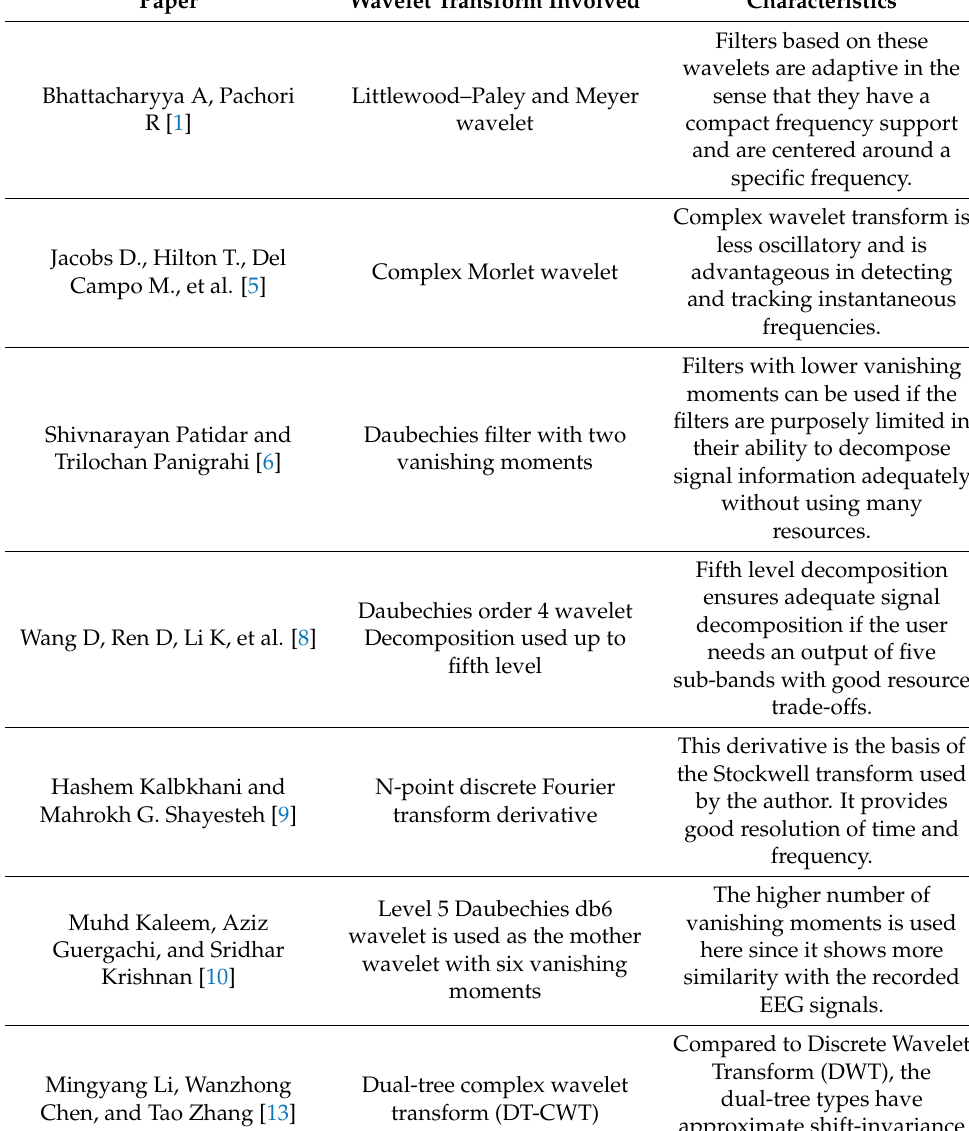
Table 1. Wavelet transforms used in the selected papers